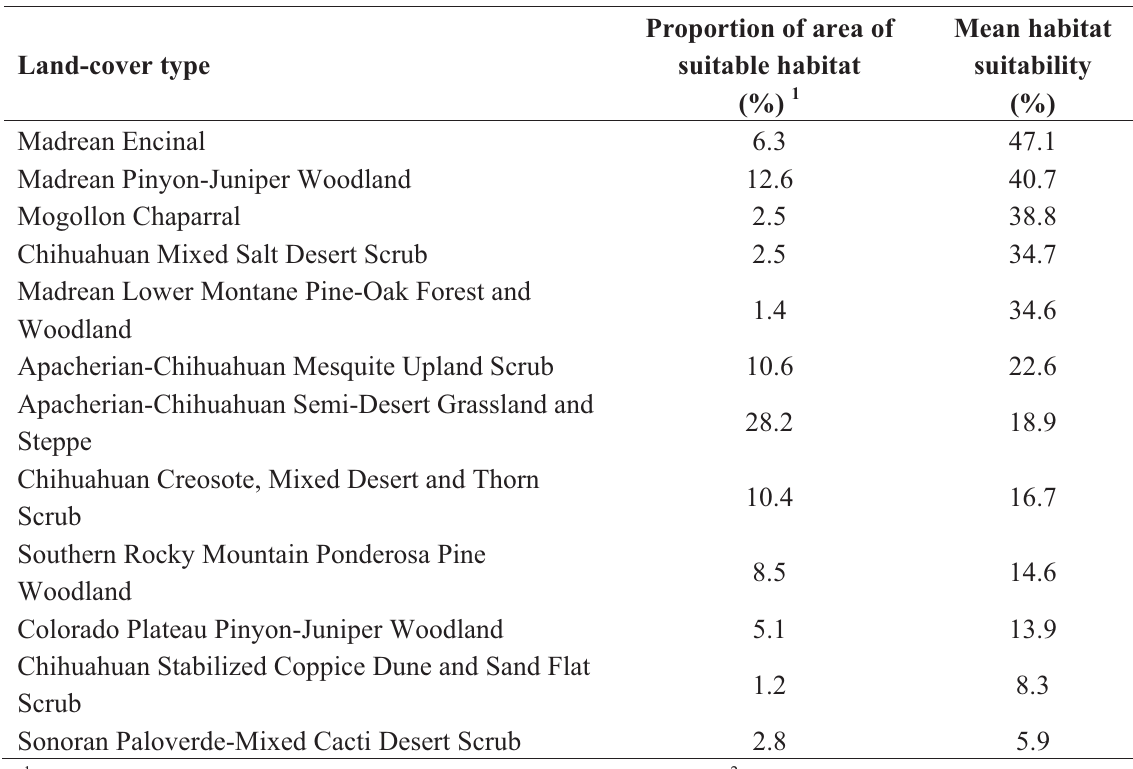
Table 5. Mean suitability of important land-cover types for the white-nosed coati ( Nasua narica ) in Arizona and New Mexico based on the best a priori set of occurrence records (see Tables 3 and 4). Only land-cover types accounting for >1% area of suitable habitat are